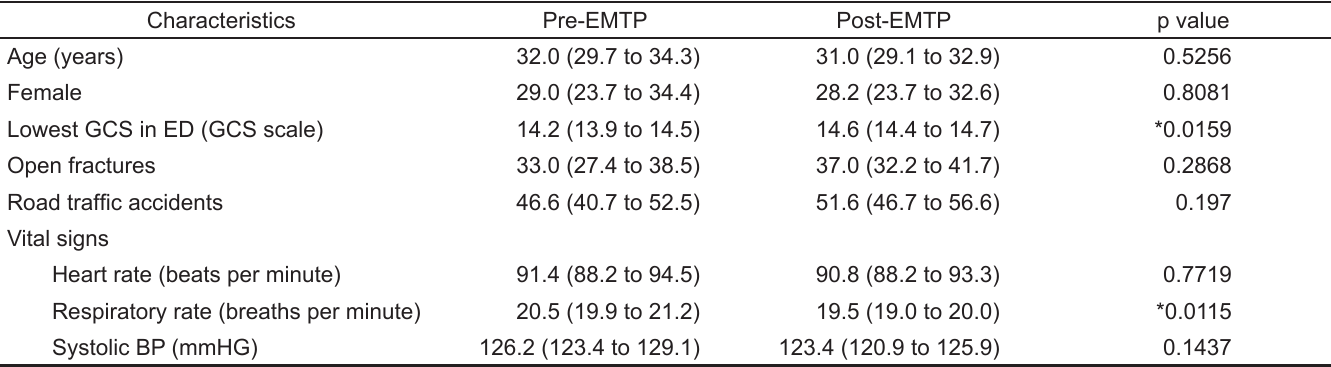
Table 3. Baseline Characteristics: Pre- and